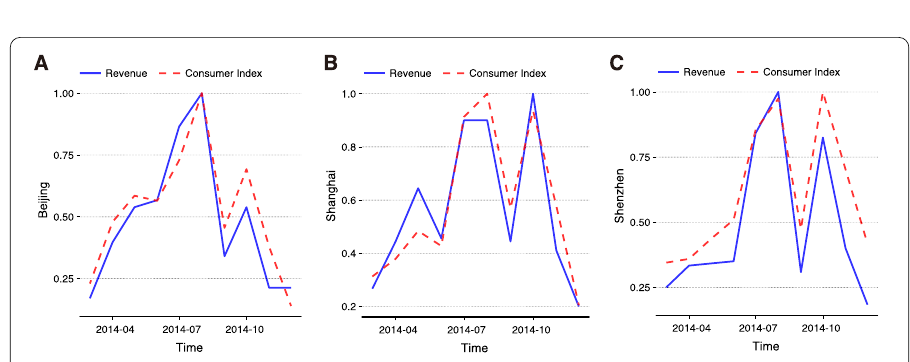
Figure 4 Consumer index for commercial areas. (A) The orange line is the monthly consumer index, which is normalized by the mean value of the year 2014, and the Spring Festival is marked by the grey bar. (B) Monthly year-over-year growth rate. The consumer index generally climbed during the summer holiday (July and August) and before the Spring Festival (December and January) and decreased during the Spring Festival (February). The year-over-year growth rate fluctuated, with more dips below zero than spikes over time, indicating that the consumer index trend decreased.